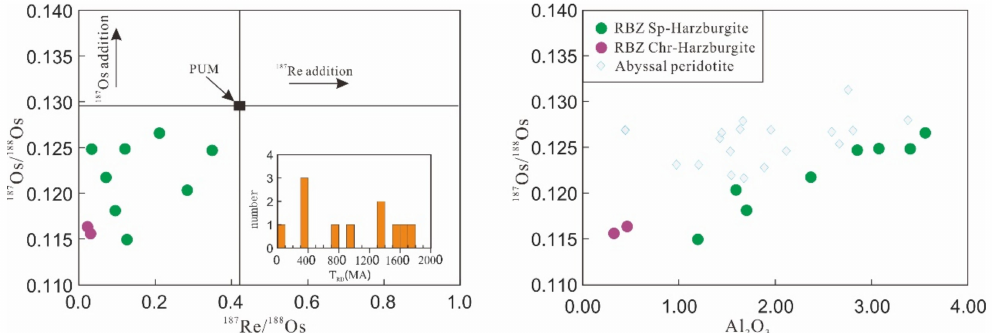
Figure 7. Re-Os isotope values from the Raobazhai harzburgites. The PUM recommended value comes from [28] and the abyssal peridotite isotopes are plotted according to